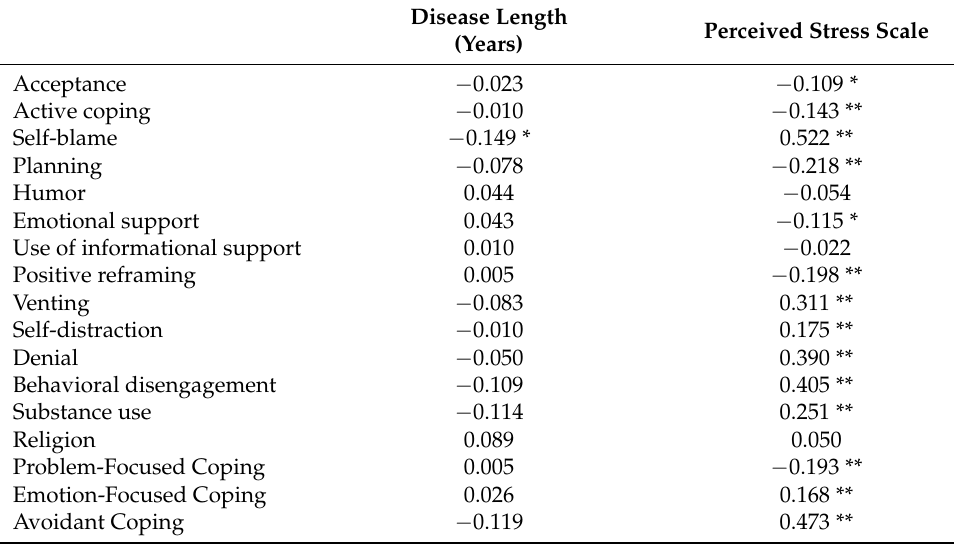
Table 5. Rho Spearman range correlations for coping strategies and disease length and coping strategies and perceived stress